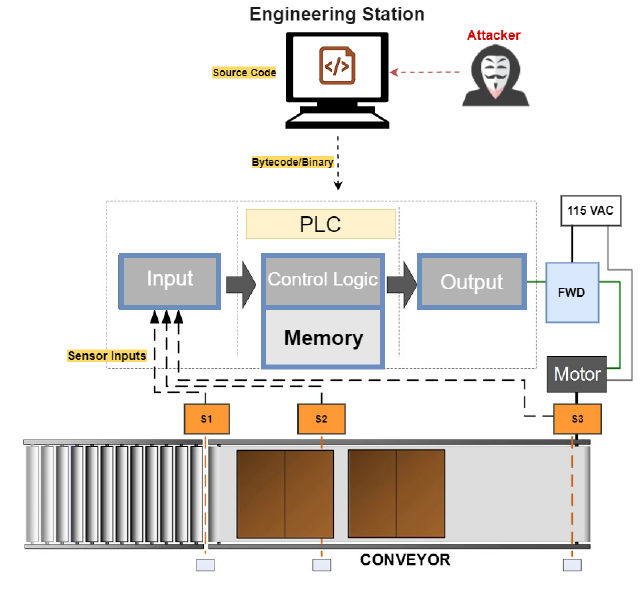
Figure 5. Attack scenario